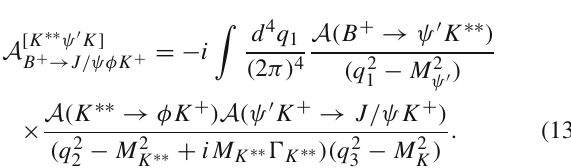
Fig. 3 Real and imaginary parts of the rescattering amplitude in Eq. (5). Motion with the increasing invariant mass M J /ψ K + is counter- clockwise